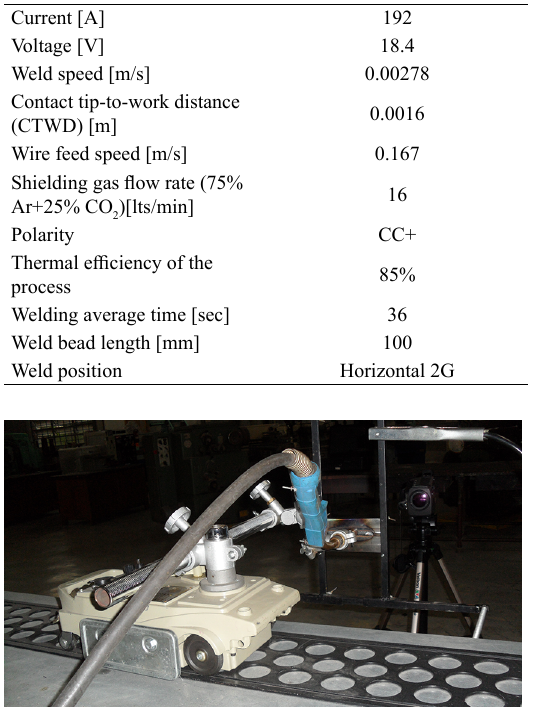
Table 2. Welding parameters used in the experiment.